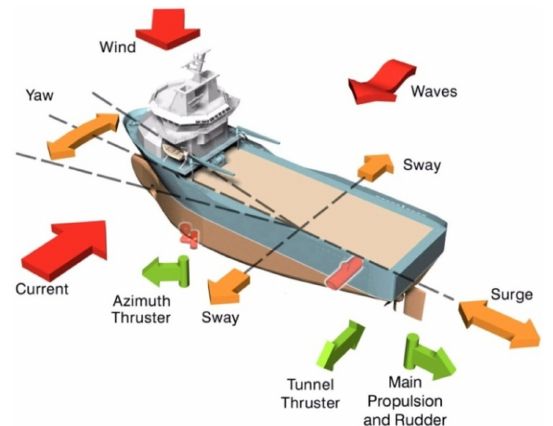
Figure 1: To stay in position, a dynamically posi- tioned vessel must automatically counter- act environmental forces and moments from wind, waves and current by active use of its thrusters. Illustration: